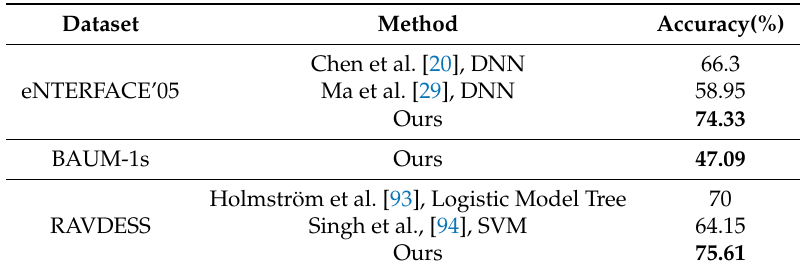
Table 1. The performance comparison of audio emotion recognition with previous works on the eNTERFACE’05, BAUM-1s, and RAVDESS datasets.